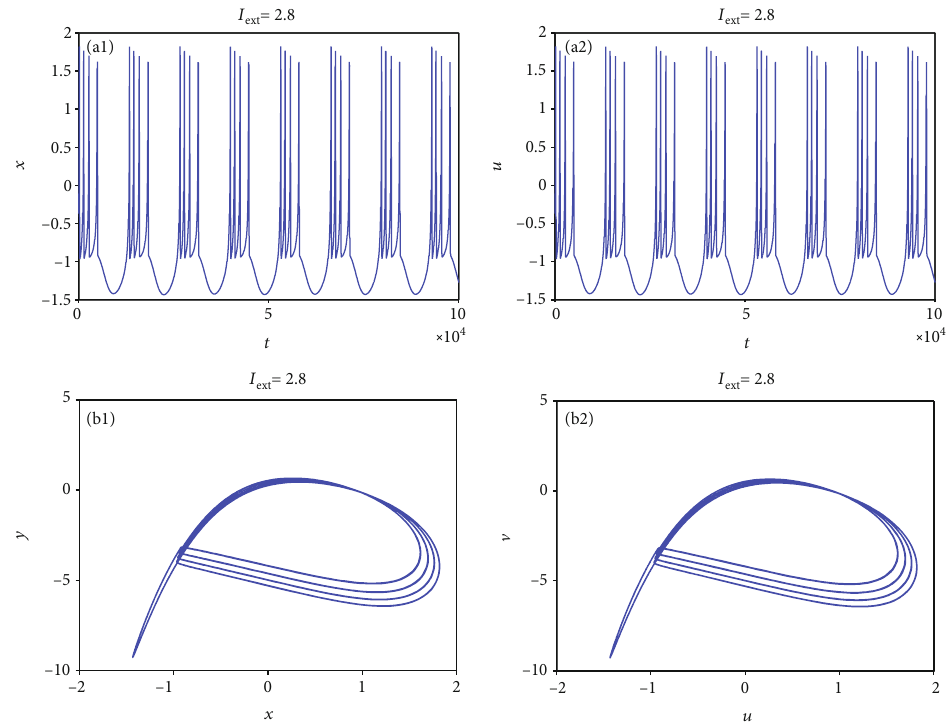
Figure 4: Period-4 fi ring pattern of model (2) when I Phase